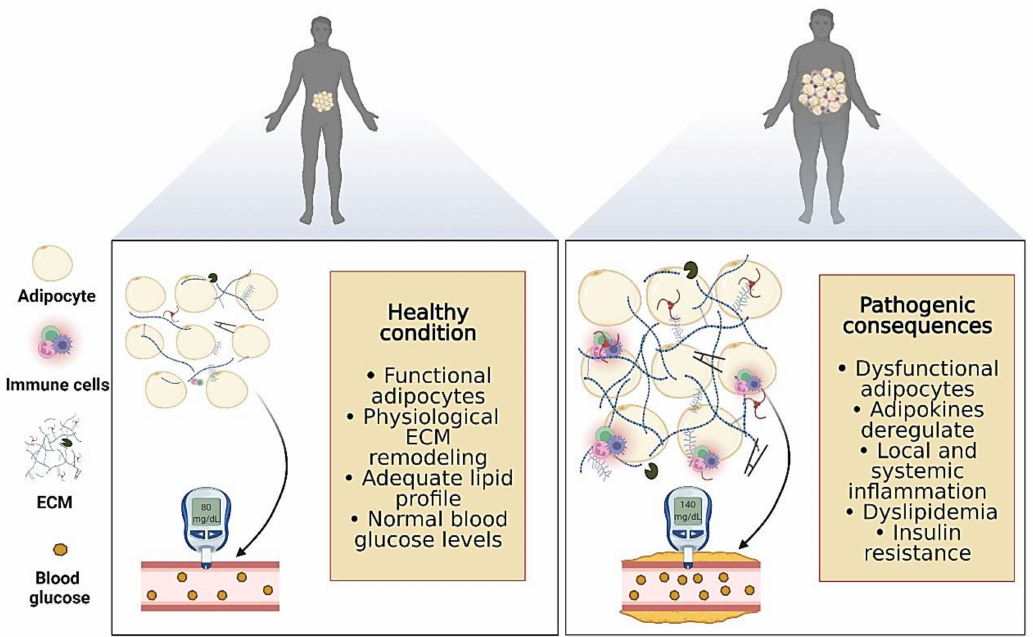
Figure 3. Schematic representation of the healthy condition and pathogenic signals in response to adipose tissue growth during chronic non-transmissible diseases. Biorender web-based software was used to create the figure (License Number